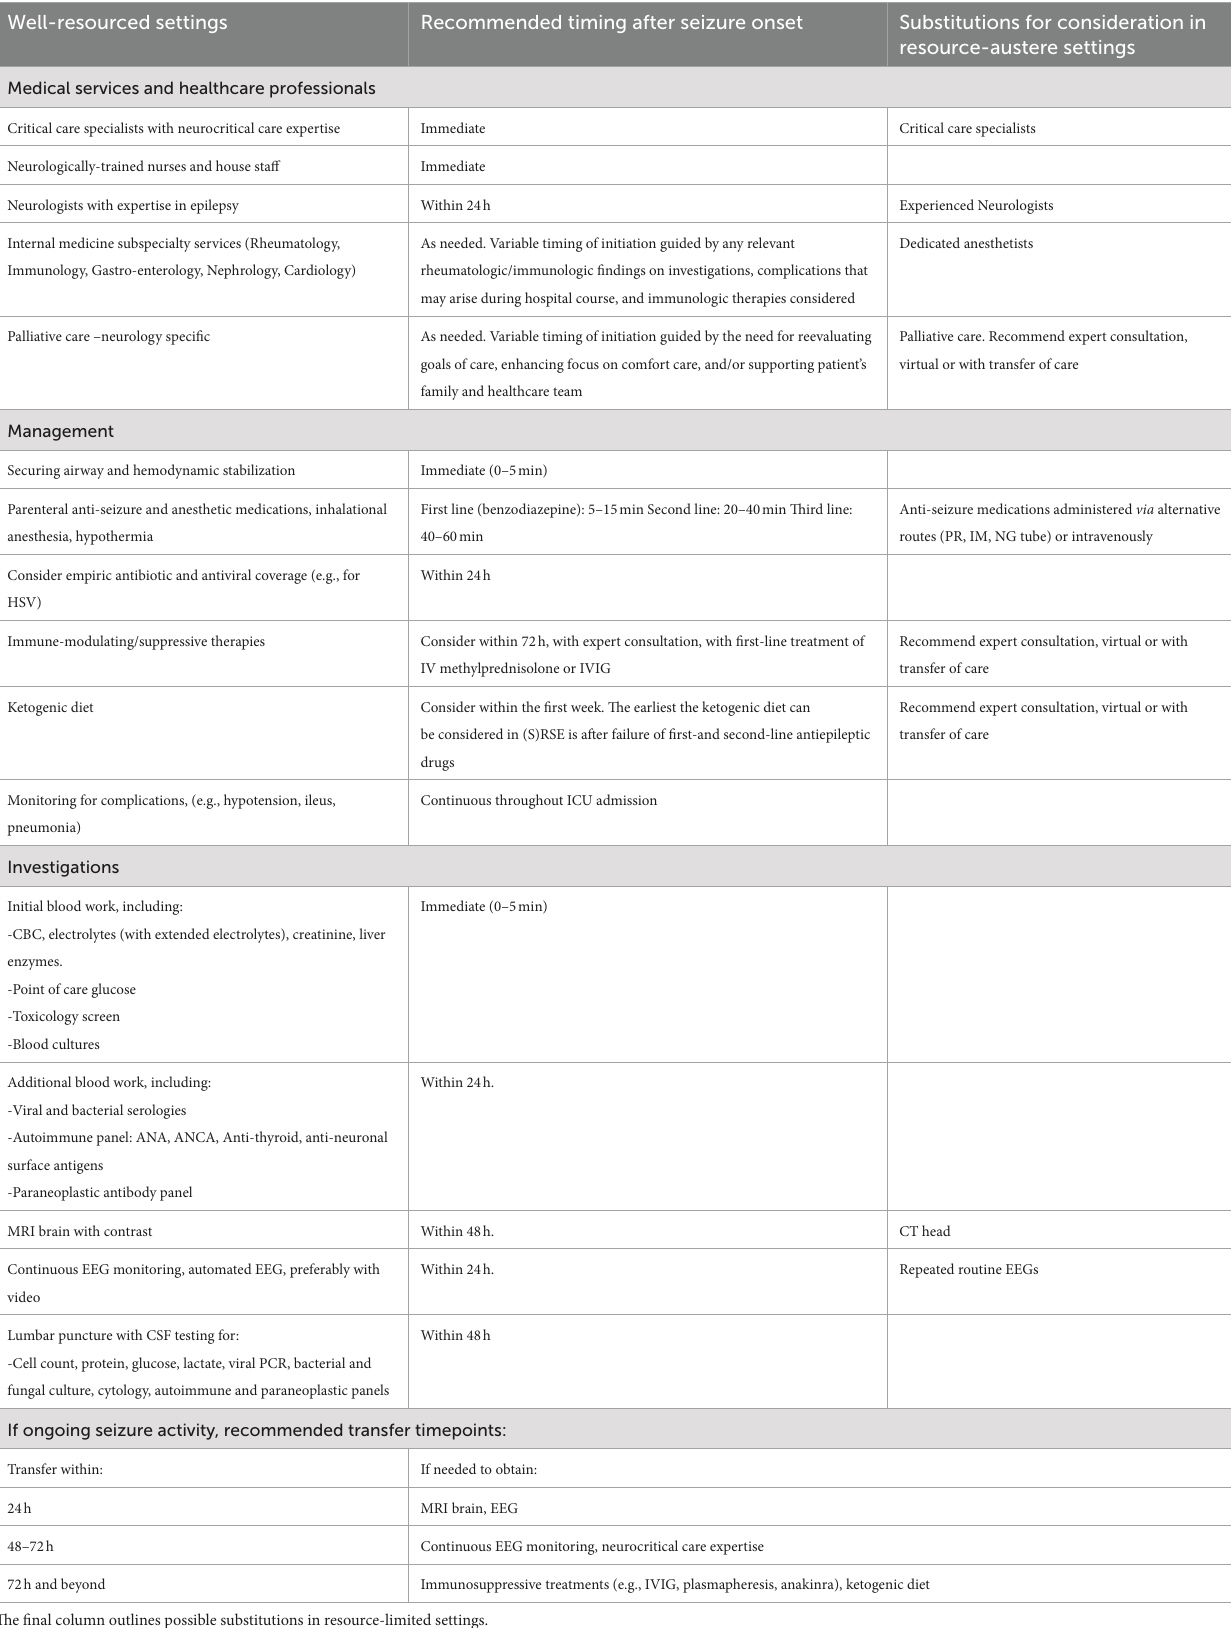
resource-austere